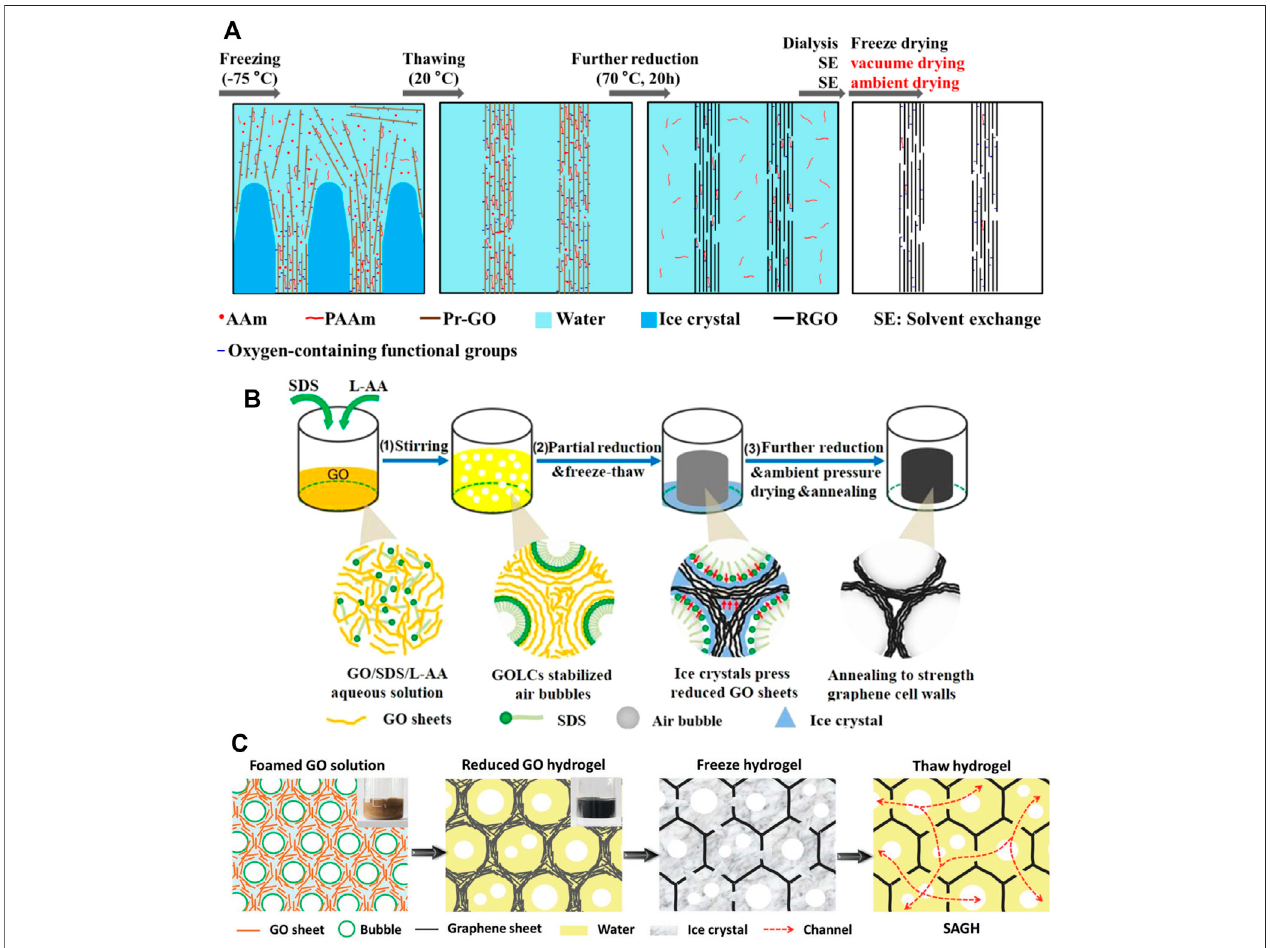
FIGURE2|(A) Schematicmodelfortheformationofthe3GAthrough insitu polymerization ofAam(Lietal.,2016). (B) Illustrationofthepreparationprocessofthe 3GAby using GO liquid crystal-stabilized bubbles asa template (Zhanget al., 2019). (C) Schematic illustration of the air-dryable graphene hydrogel byusing ice crystals and air bubbles as templates (Yang et al.,